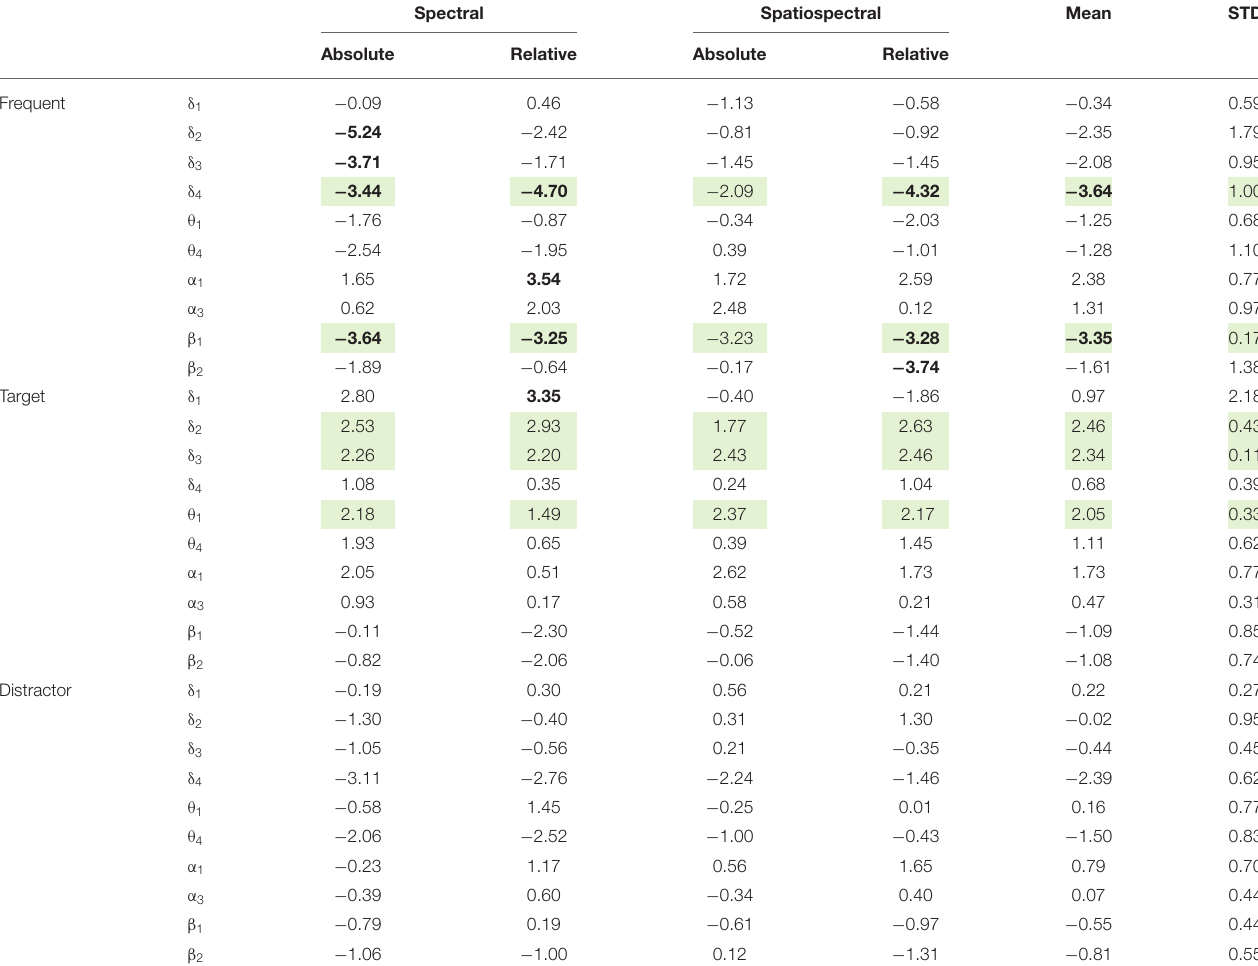
Bold highlighted t-values demonstrated significant relationship with p FWE < 0.05. Green-color highlighted rows indicate the patterns with significant task-related relationships. These patterns demonstrated p FWE < 0.05 or a mean over models of p < 0.05 (i.e., mean |t| > 2.0) with t-value standard deviation of STD